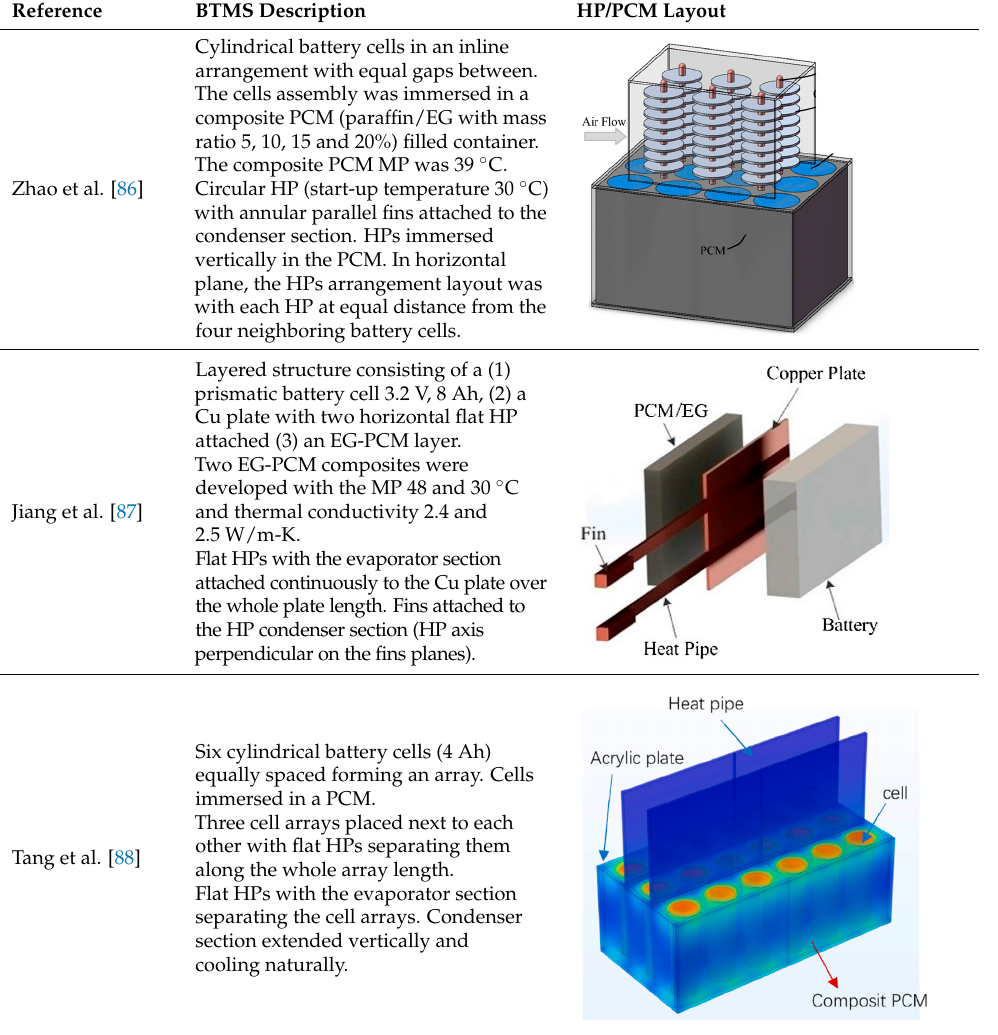
Figure 25. ( a ) Maximum temperature of the battery pack; ( b ) Temperature difference of a single cell; ( c ) Temperature difference of all cells [85]. Reproduced with permission from Elsevier. Various HP – battery systems layouts exist as presented in Table 4. In general, HPs have some form of fins for efficient dissipation of heat. Table 4. PCM-based BTMSs with HPs for thermal performance enhancement.